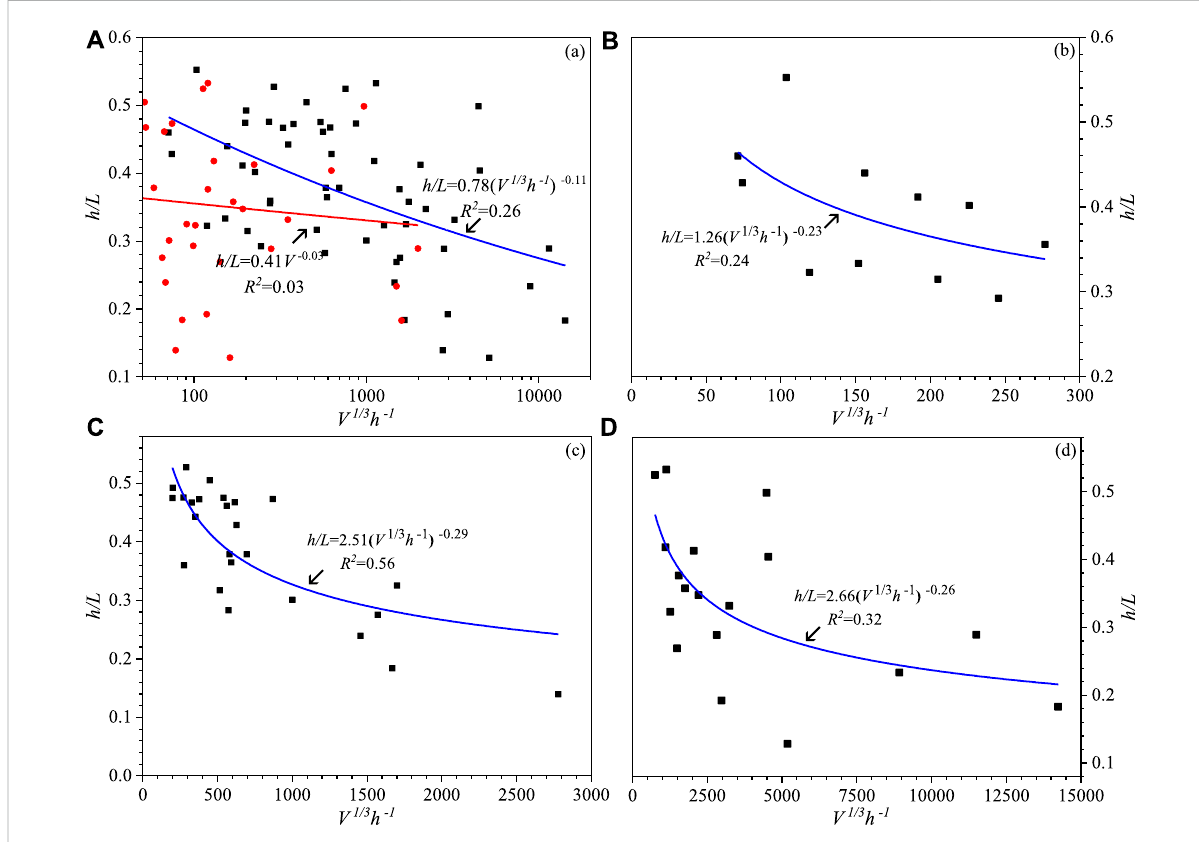
FIGURE 7 Simple linear regression of the logarithm of the h / L ratio predicted from the logarithm of V 1/3 / h or V without consideration of the local topography: (A) Regardless of the volume effect; (B) large-scale rock avalanches; (C) medium-scale rock avalanches; (D) small-scale rock avalanches.